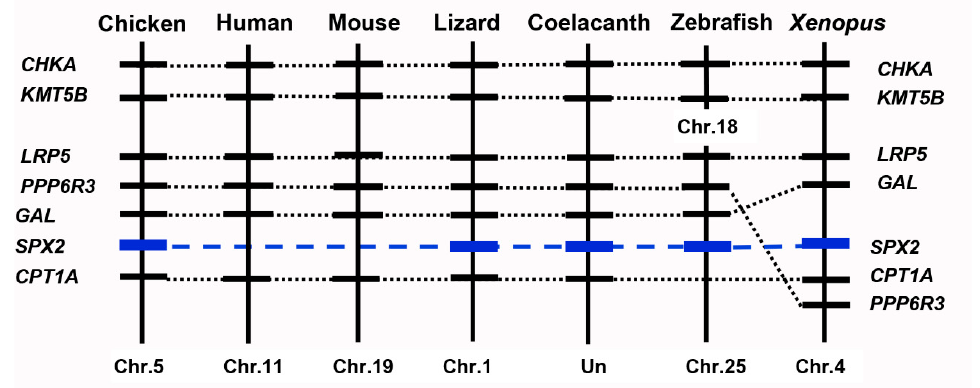
Figure 3. Conserved synteny for the genomic location of chicken SPX2 with its orthologous gene in other vertebrates. Based on existing genome assemblies, SPX2 is absent in humans and mice. Dotted lines indicate the syntenic genes, and dashed lines denote the location of SPX2 . Note: genome assemblies of Chicken (GRCg7w), Human (GRCh38.p13), Mouse (GRCm39), Lizard (AnoCar2.0v2), Coelacanth (LatCha1), Zebrafish (GRCz11), and Xenopus (UCB_Xtro_10.0) as well as their gene notation information from Ensembl were used in the analysis.